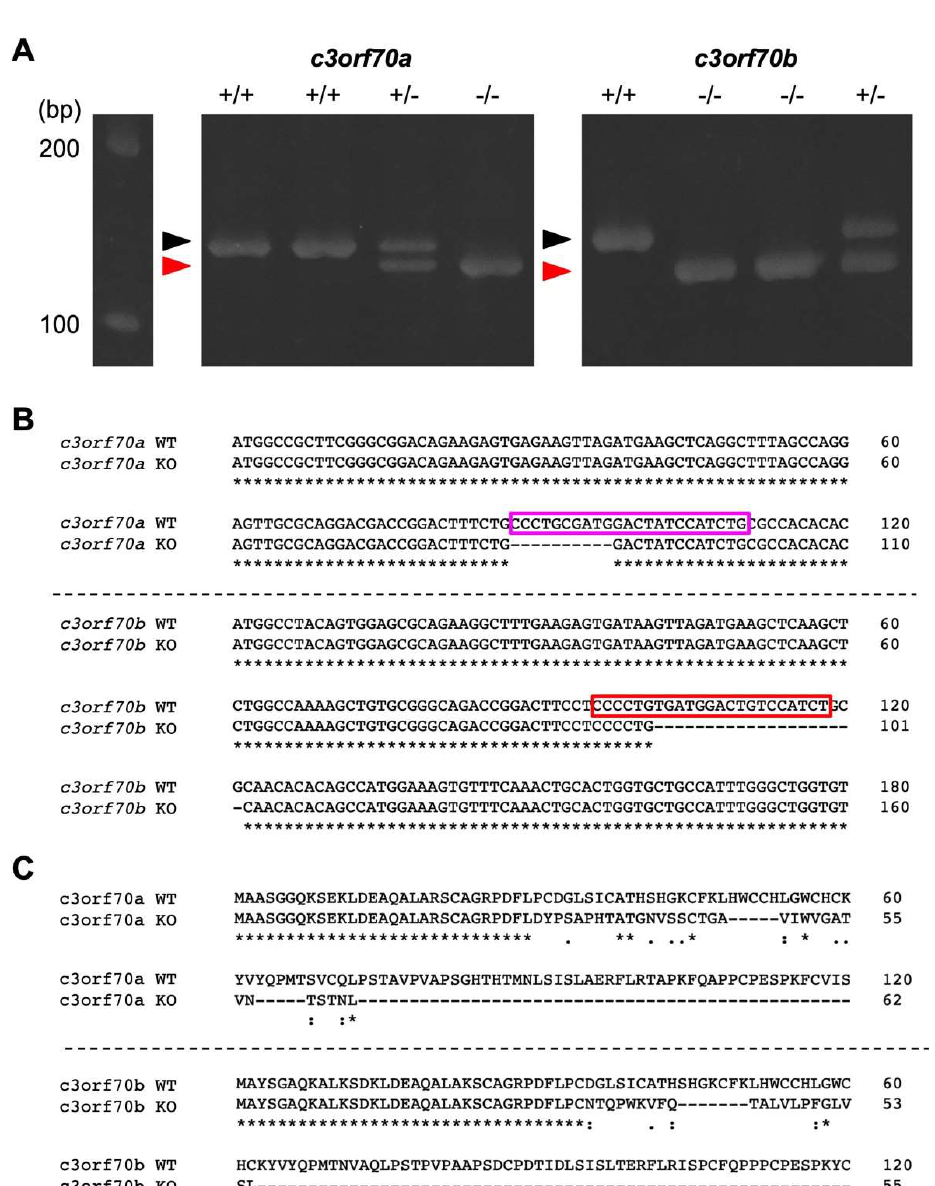
Figure 3. Generation of c3orf70-KO zebrafish. ( A ) Heteroduplex mobility assay of PCR products after amplification of the crRNA-targeted genomic region of c3orf70a and c3orf70b . Genomic DNA was extracted from c3orf70 wild-type (WT) and c3orf70-KO zebrafish and subjected to PCR to amplify short fragments of the c3orf70a and c3orf70b genes, including their crRNA target sites. The PCR products were electrophoresed in a 10% acrylamide gel. The positions of the expected homoduplexes for WT and KO zebrafish are indicated by black and red arrowheads, respectively. ( B ) Nucleotide sequence alignment of c3orf70a and c3orf70b genes from WT and KO zebrafish. The recognition sites of crRNA targeting c3orf70a and c3orf70b, including the PAM sequences, are shown in magenta and red boxes, respectively. ( C ) Alignment of amino acid sequences inferred from cDNA of c3orf70a and c3orf70b from WT and KO zebrafish.